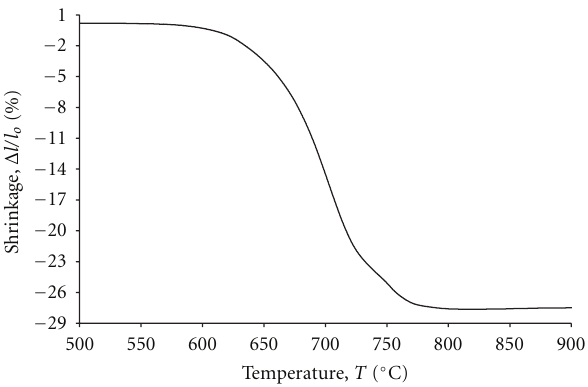
Figure 2: Linear shrinkage versus temperature of the selected glass.